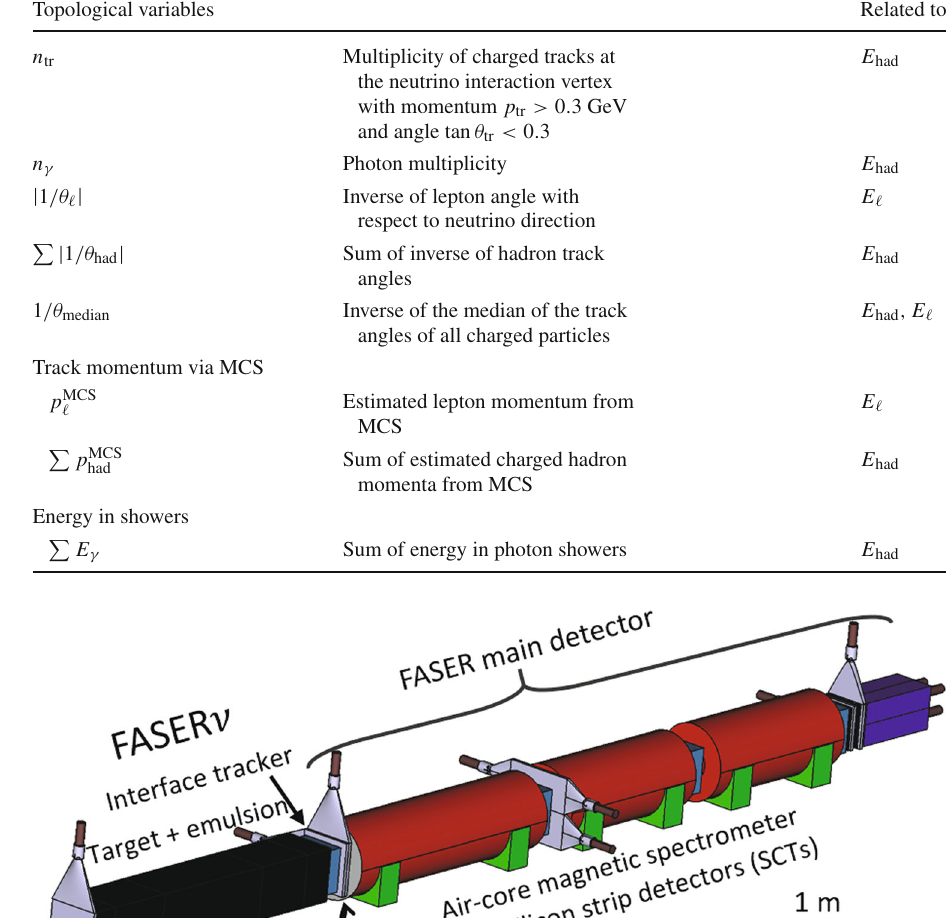
Fig. 11 Left : Neutrino energy and sum of visible energy (momentum of charged particles and energy of electromagnetic showers) for ν μ CC samples with at least five charged tracks n tr ≥ 5, with smearing (MC). The effect of the 7 TeV upper limit used in the MCS method is visi- ble near the top of the figure. Center : Neutrino energy reconstruction